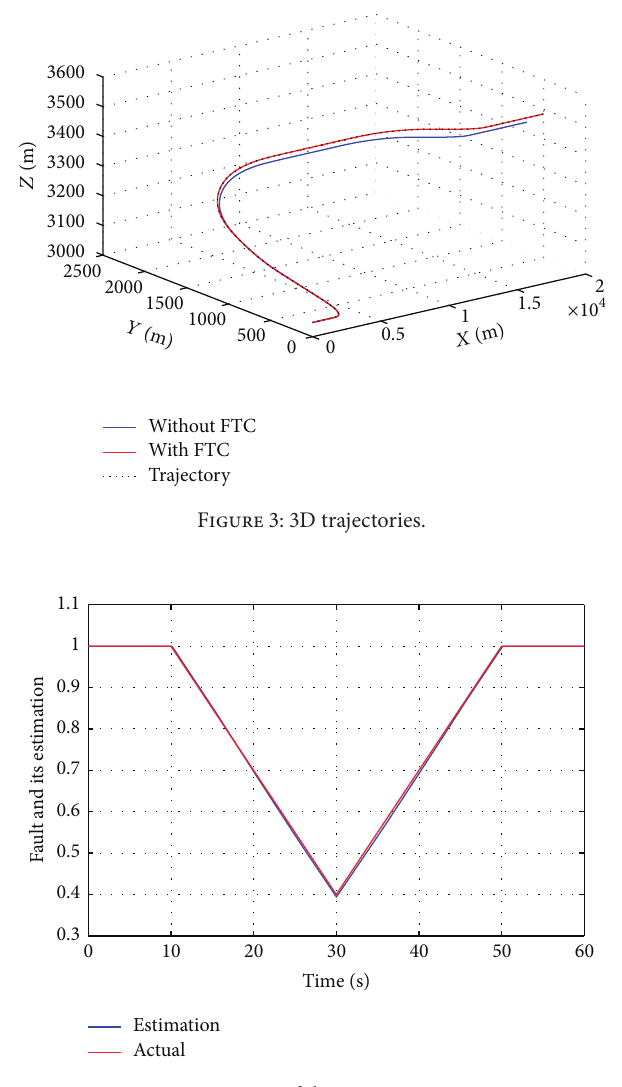
Figure 4: Response of the parameter